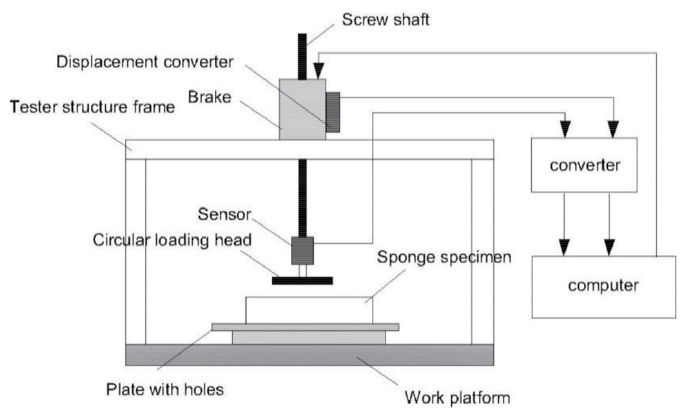
Figure 4. Mechanical test system